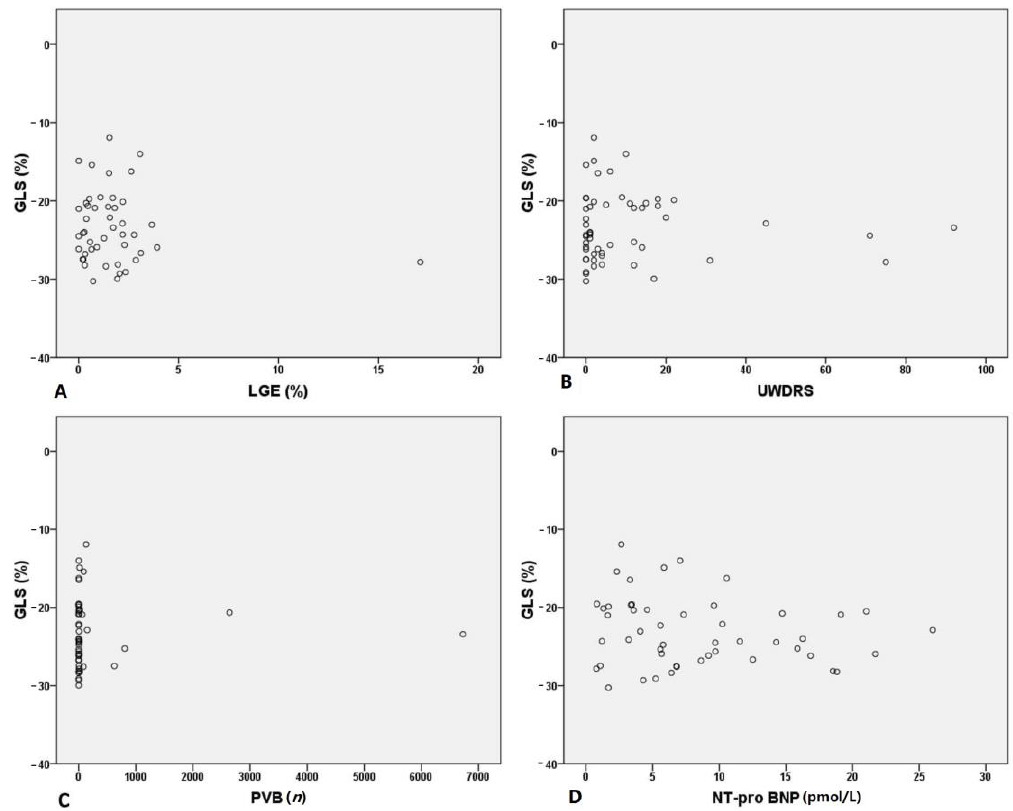
Figure 1. Correlation analysis of global longitudinal strain (GLS) and late gadolinium enhancement (LGE) ( A ), Unified Wilson’s Disease Rating Scale (UWDRS) ( B ), premature ventricular beats (PVB) ( C ) and NT-pro BNP ( D ).